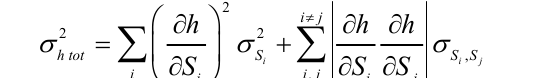
Table 3 resumes the functional models connected to the methods for monostatic-bistatic DEM